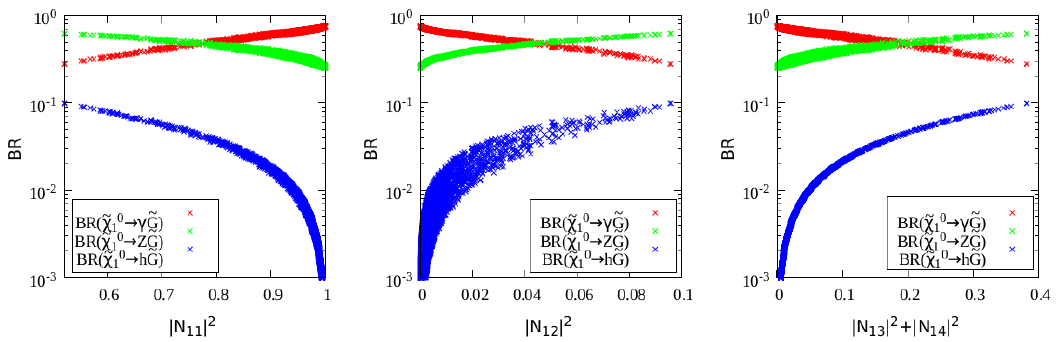
Figure 3 . Vatiation of the three relevant BRs of components. The red, green and blue lines correspond to BR( BR( (cid:31) 0 ! h e G ) e 1